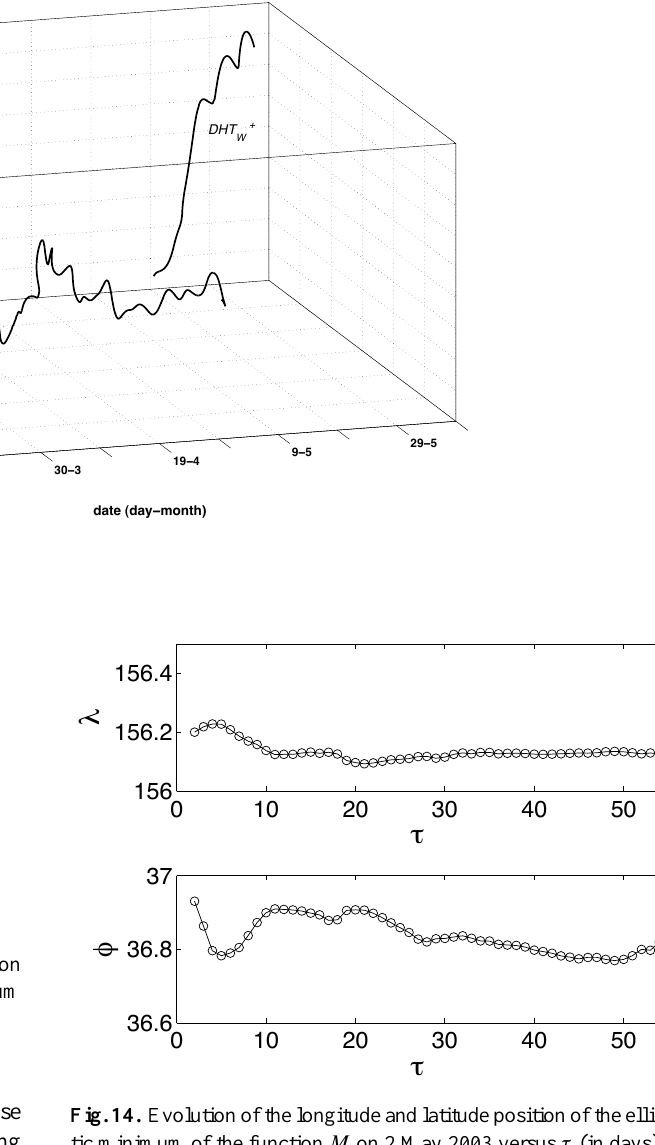
Fig. 14. Evolution of the longitude and latitude position of the ellip- tic minimum of the function M on 2 May 2003 versus τ (in